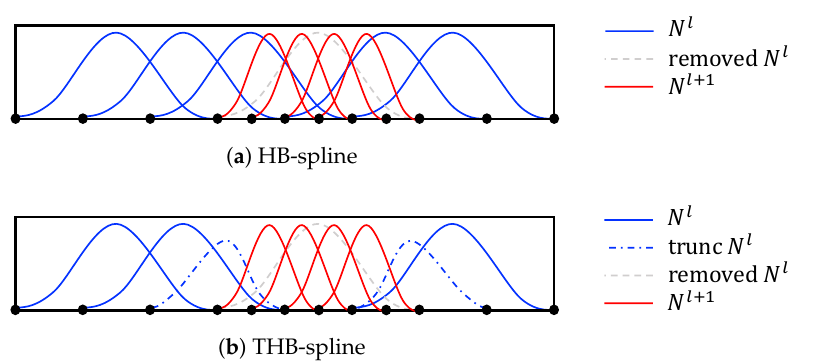
Figure 8. Illustration of the basis functions of a two-level ( a ) hierarchical B-spline and ( b ) truncated hierarchical B-spline. The N l in the dashed line can be represented by a linear combination of N l + 1 , and is therefore removed to avoid linear dependence.